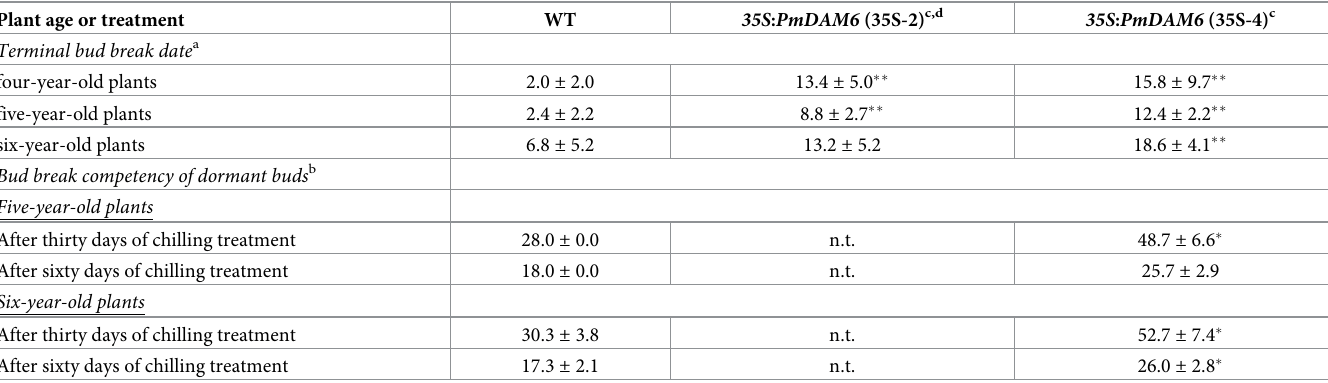
Table 2. Delayed bud break timing and repressed bud break competency of dormant terminal buds of 4- to 6-year old 35S : PmDAM6 apple plants. Plant age or